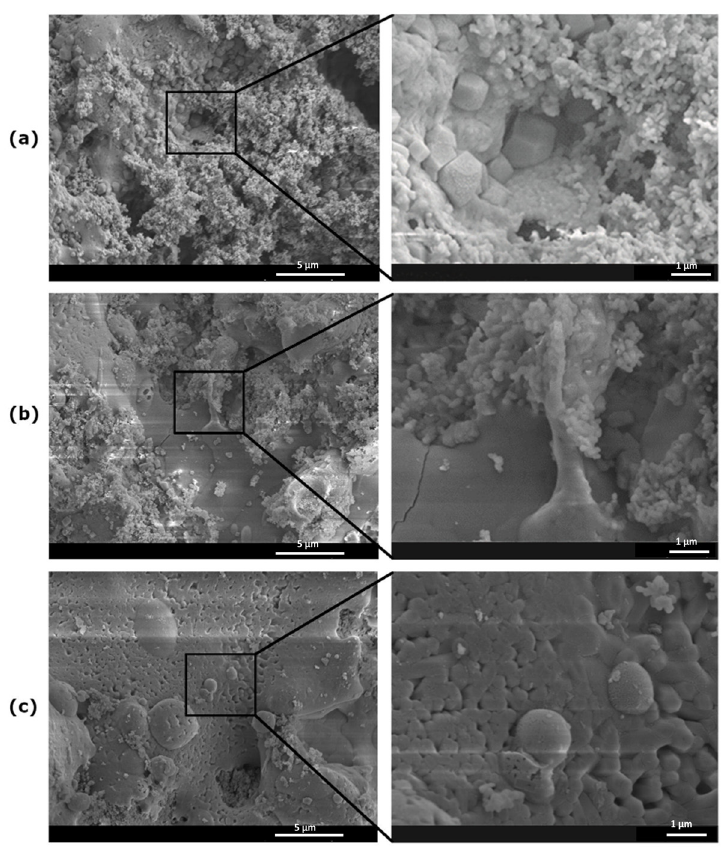
Figure 5. Morphologies of the surfaces of HA coatings at low and high magnification; ( a ) HA1, ( b ) HA2, ( c ) HA3.